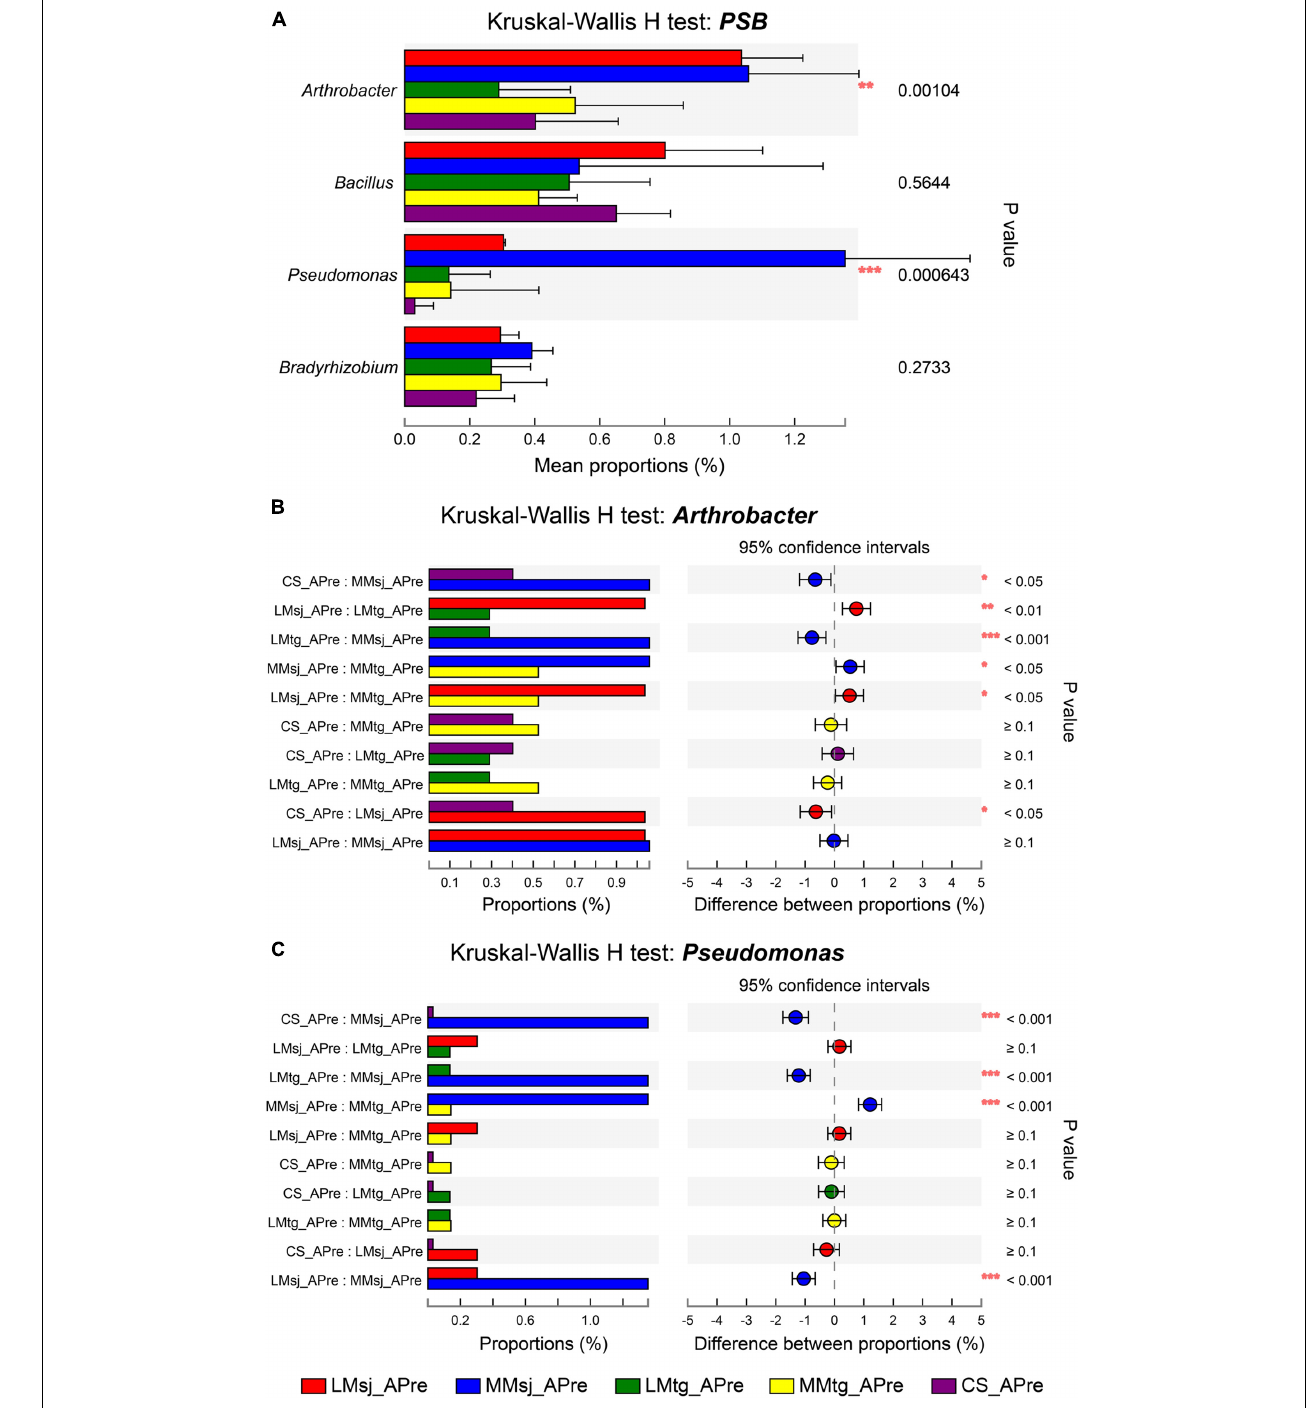
FIGURE 3 | (A) The Kruskal-Wallis H test bar plot for phosphate-solubilizing bacteria after drought-flood abrupt alternation (DFAA)/natural rainfall. (B) The post hoc plot of Kruskal-Wallis H test of genus Arthrobacter . (C) The post hoc plot of Kruskal-Wallis H test of genus Pseudomonas . * P < 0.05; ** P < 0.01; *** P < 0.001.